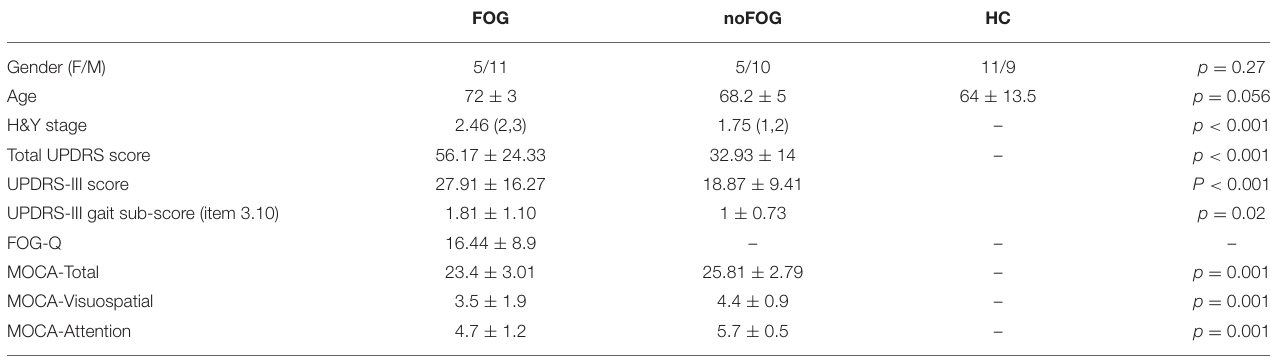
TABLE 1 | Demographic, and clinical characteristics of the study groups.